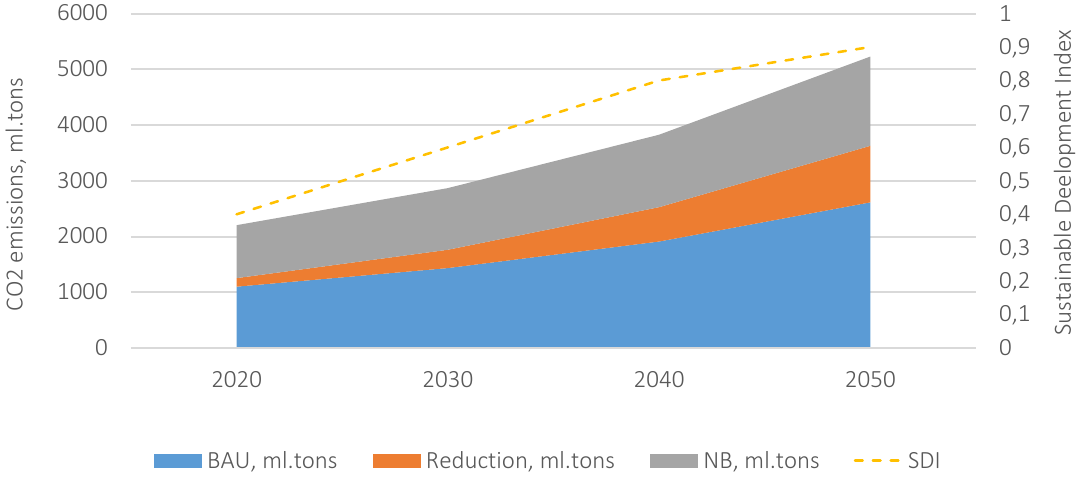
Figure 4. Estimated level of CO2 emissions reductions for world fleet and development of